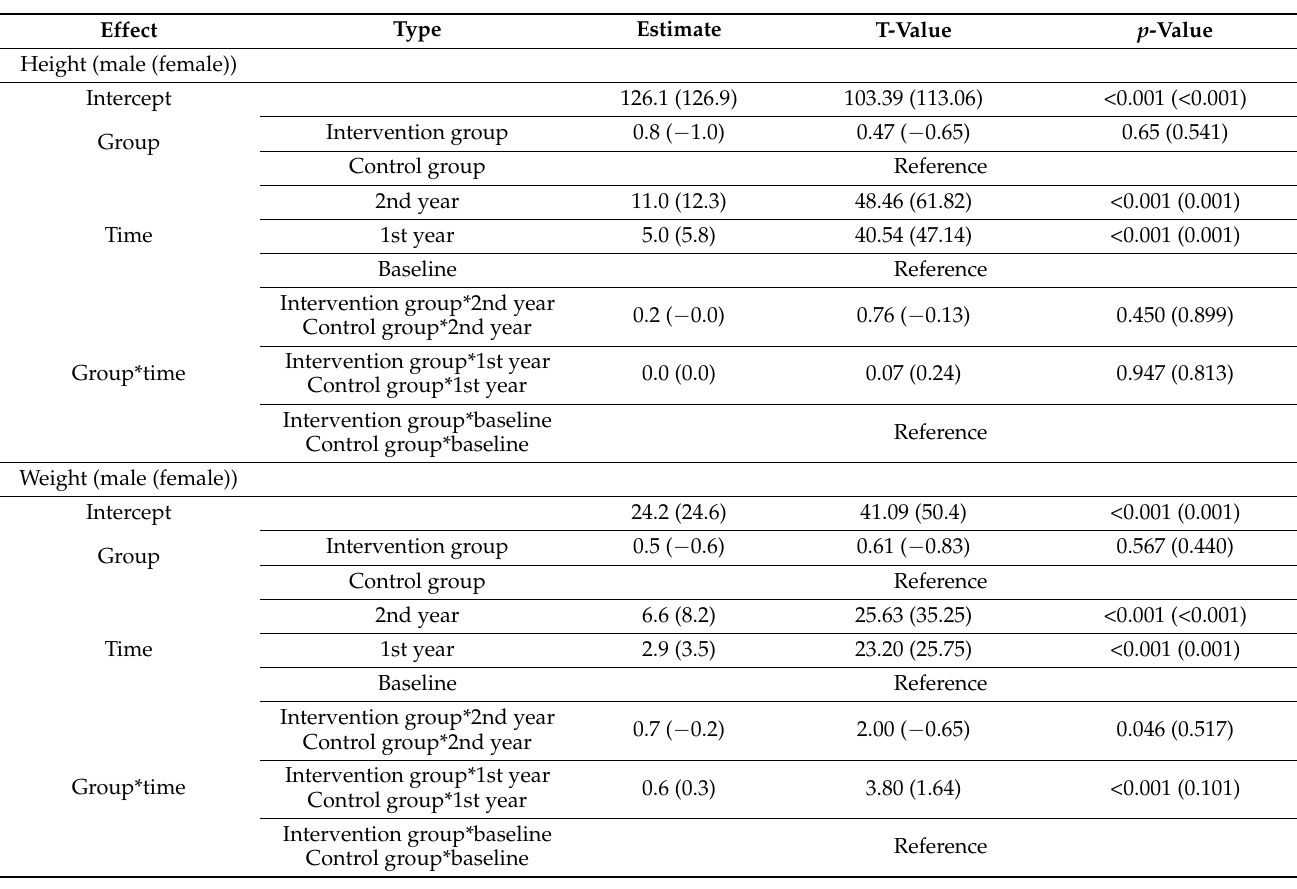
Table A1. Test hypothesis results of fixed effects of height and